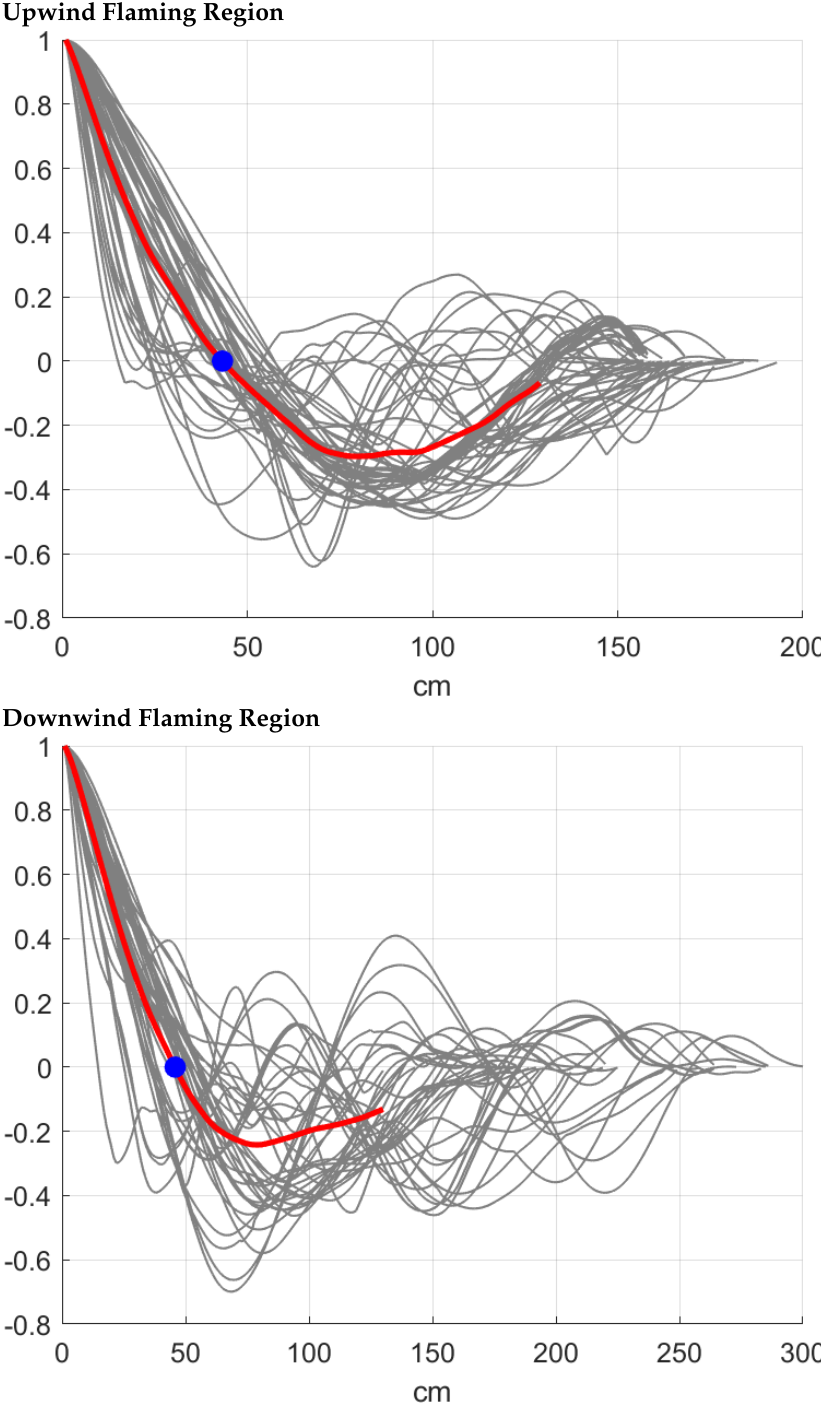
Figure 11. The mean-shifted autocorrelation of the y coordinate of all isotherms (gray) and their average (red). The chosen length scale is the first root of the autocorrelation function which is about 48 cm for the upwind side and 46 cm for the upwind